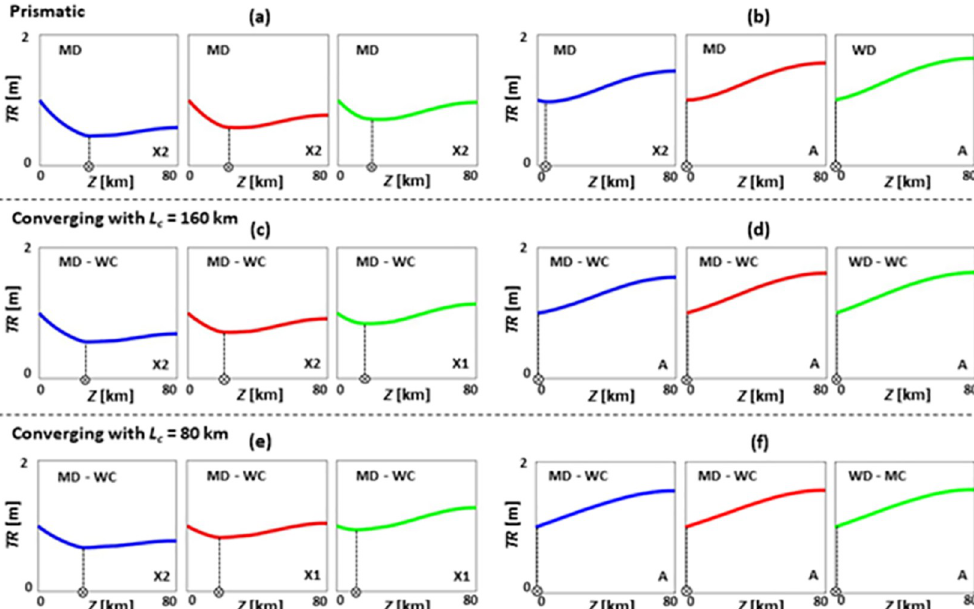
Fig 7. Influence of channel dredging on tidal range TR patterns of prismatic (a, b), converging with L c = 160 km (c, d), and converging with L = 80 km (e, f) estuaries under SLR, where TR = 1 m, Q / TP = 1% (low river discharge), Z = 80 km, c 0 n = 0.03 s/m 1/3 , and θ = 0˚. In (a), (c), and (e) h = 5 m, and in (b), (d), and (f) h = 10 m. Blue, red, and green colours show base case (no SLR), 1 m of SLR, and 2 m of SLR scenarios, respectively. Patterns X1, X2, and A are the general TR patterns introduced in Fig 2. WD, MD, WC, and MC refer to weakly dissipative, moderately dissipative, weakly converging, and moderately converging estuaries,